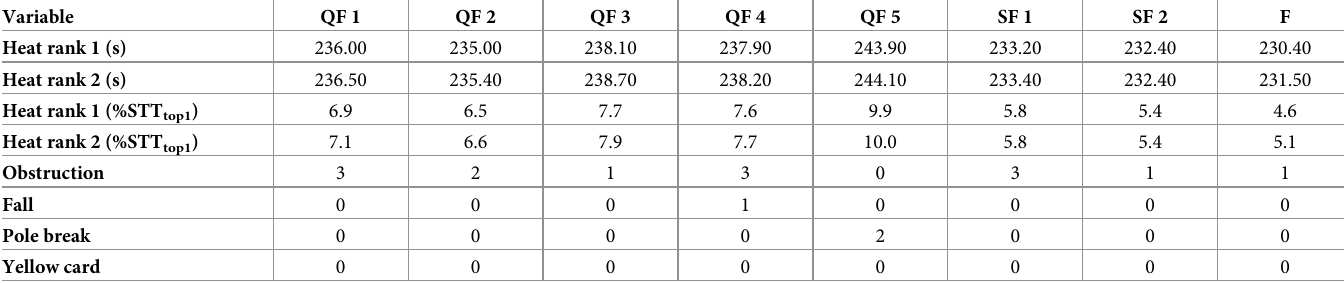
Table 1. Skiing time for the top-two finishers and number of incidents during a 1.7-km classical sprint cross-country skiing race for elite male skiers. Presented as absolute values [N = 16]. Variable